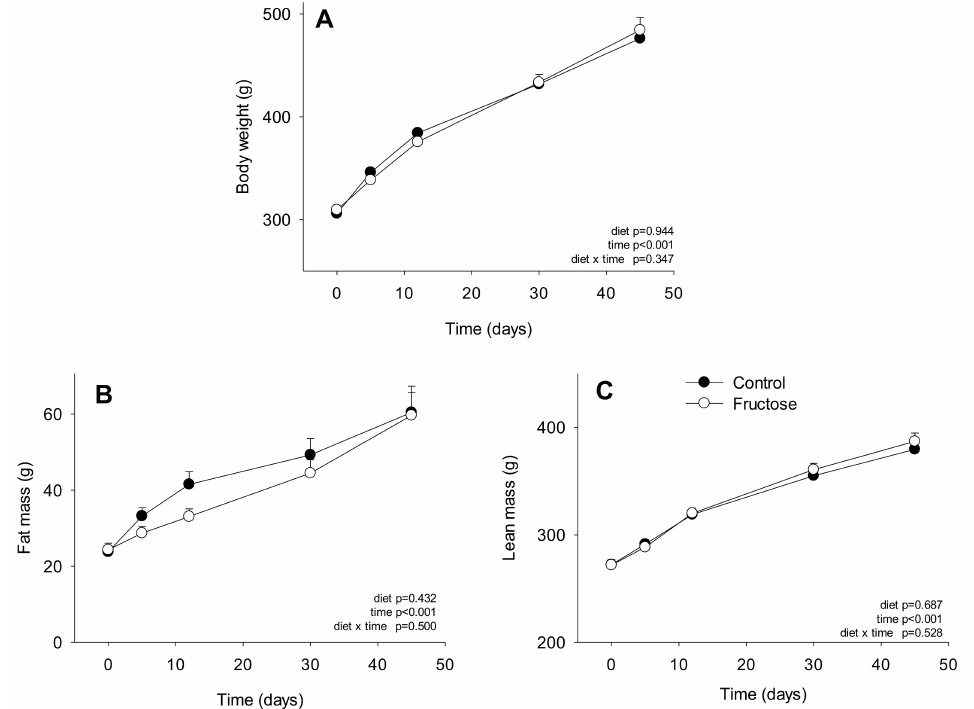
Figure 3. Body weight ( A ), fat mass ( B ), and lean mass ( C ) of rats fed on a control or high-fructose diet for 45 days. Data is presented as mean ± SEM ( n = 8). Data is expressed in grams (g) and was analyzed using two-way ANOVA